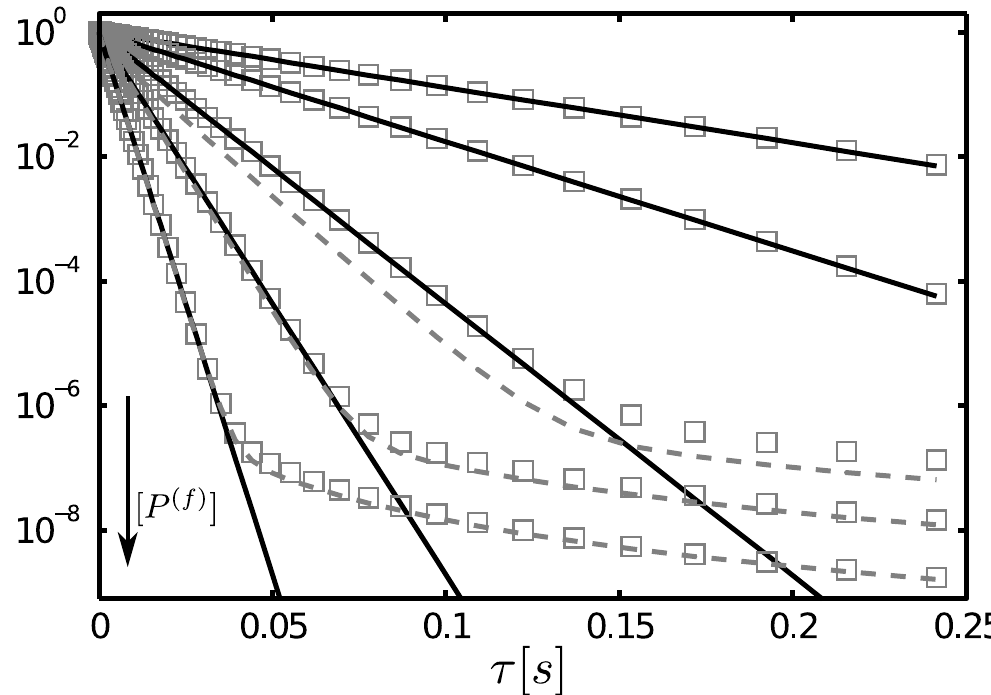
Fig 4. Normalized waiting time distribution between bindings of a single enzyme. We show with squares the dwell time distribution estimated differentiating Eq (10) as prescribed in Eq (29) and computing the integral numerically using D f = 5 μ m 2 s − 1 , V obs = 5.6 × 10 − 3 μ m 3 , [ S T ] = 1/ V obs , k on = 2 μ M − 1 s − 1 , k − s − 1 and, from top to bottom, the enzyme concentrations [ P ( f ) ] = 10, 20, 50, 100 and 200 μ M . All the distributions are normalized with respect to 1 = 0.5 their value at τ = 0. We also show the analytic expression (30) (solid curves) for all cases and Eq (31) (dashed curves) for the three cases with the largest values of [ P ( f ) ].